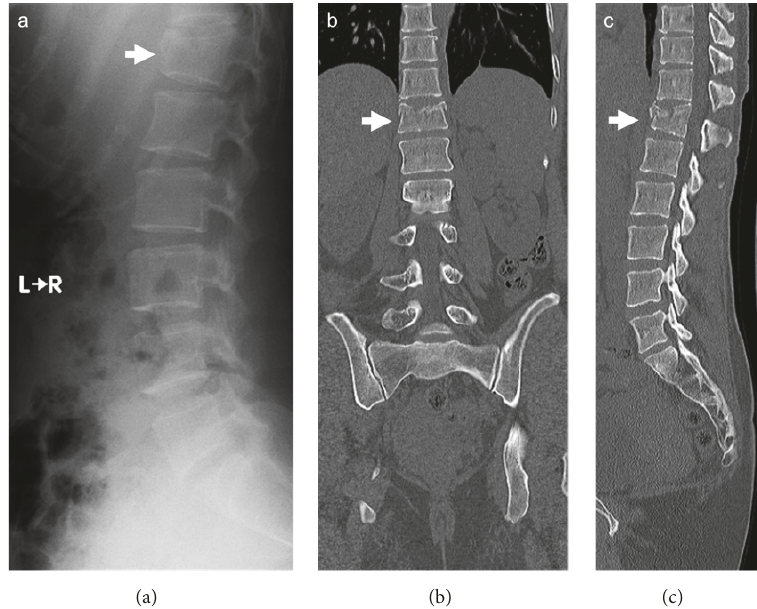
Figure 3: (a) Roentgenogram (a) and CT (b and c) showing compression fracture of Th12 (white